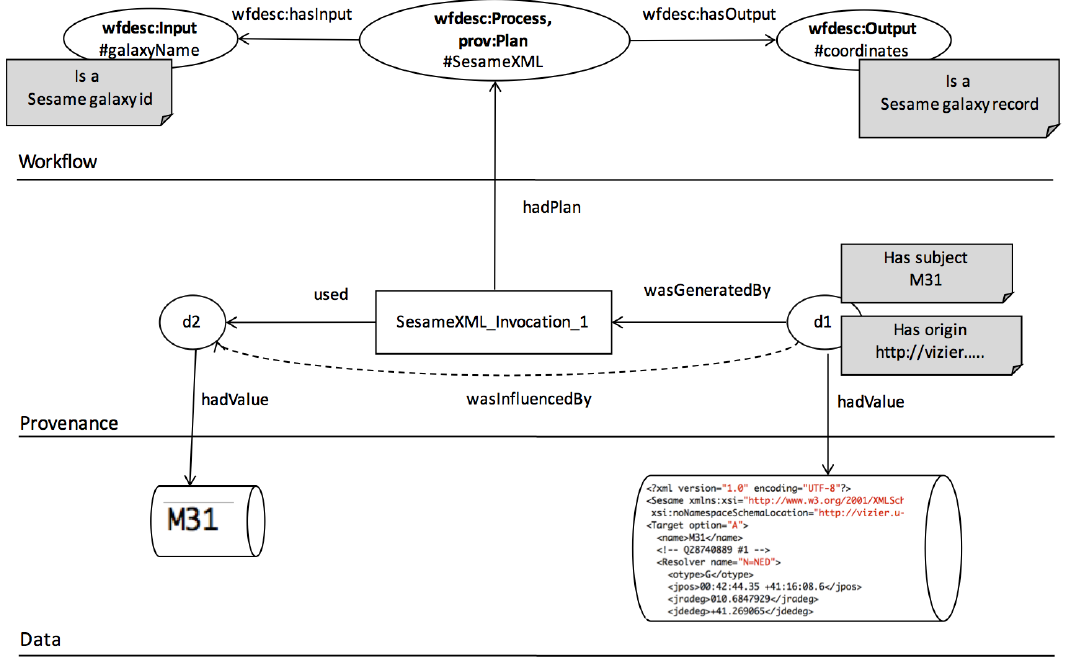
Figure 3. Illustration of Static and Dynamic Metadata at different layers of workflow